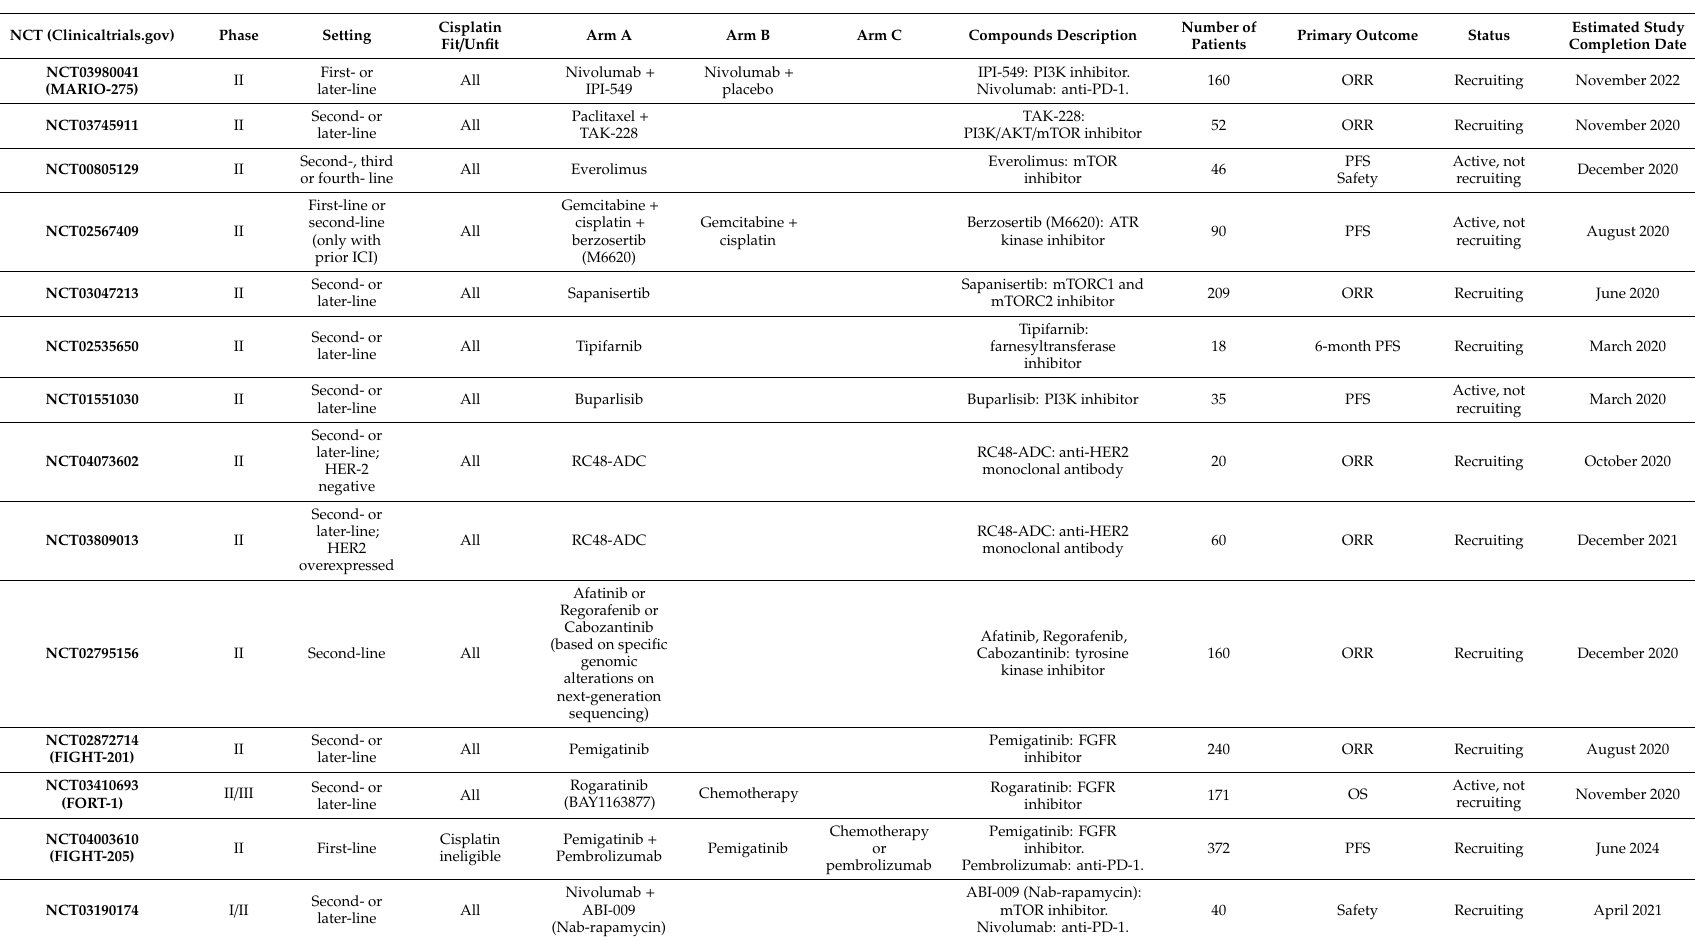
Table 7. Ongoing phase I / II / III trials of target therapies. ORR: overall response rate. PFS: progression-free survival. OS: overall survival.